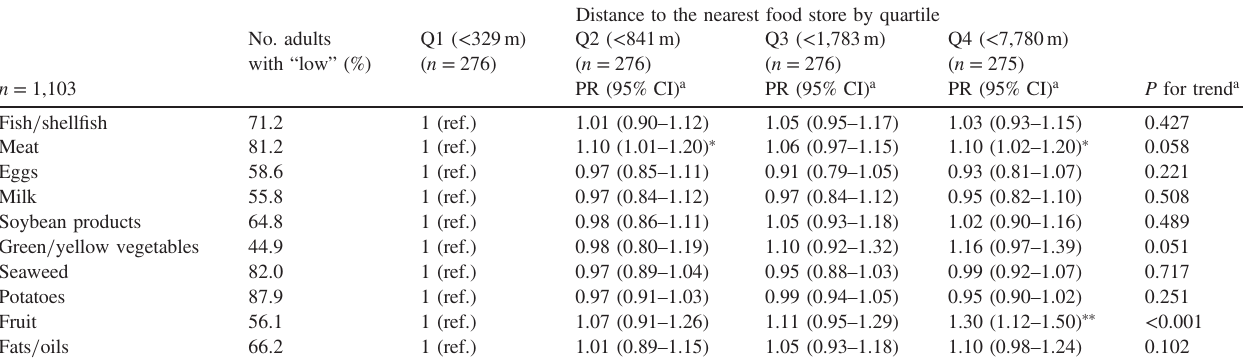
Table 3. Prevalence ratio (95% con fi dence interval) for the low frequency (once every two days or less) of consumption of each